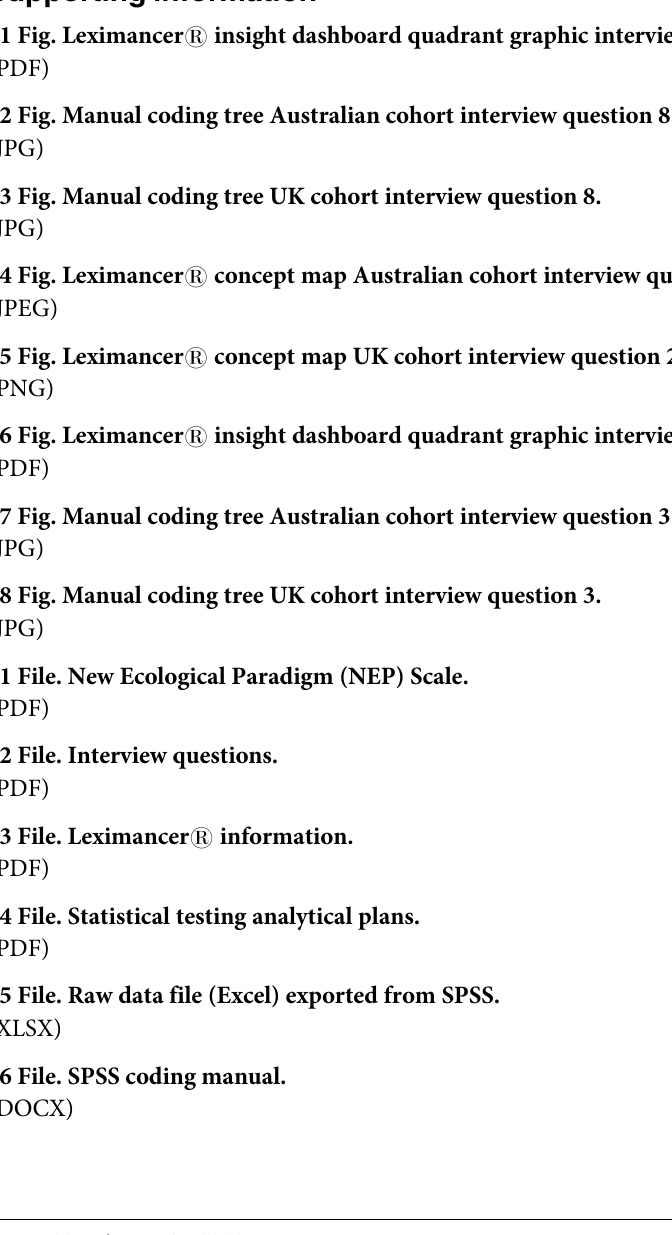
S2 Fig. Manual coding tree Australian cohort interview question 8. S3 Fig. Manual coding tree UK cohort interview question 8.